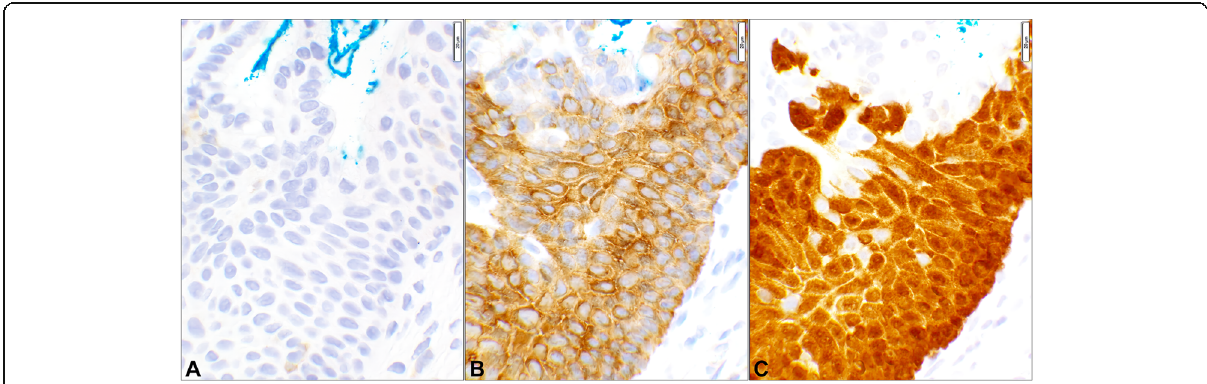
Fig. 3 Stathmin-1 false negative in high grade squamous intraepithelial lesion. The three photomicrographs are obtained from a case of high grade squamous intraepithelial lesion (Case# 13, Supplemental Table 1). A Stathmin-1 shows negative staining of the dysplastic squamous